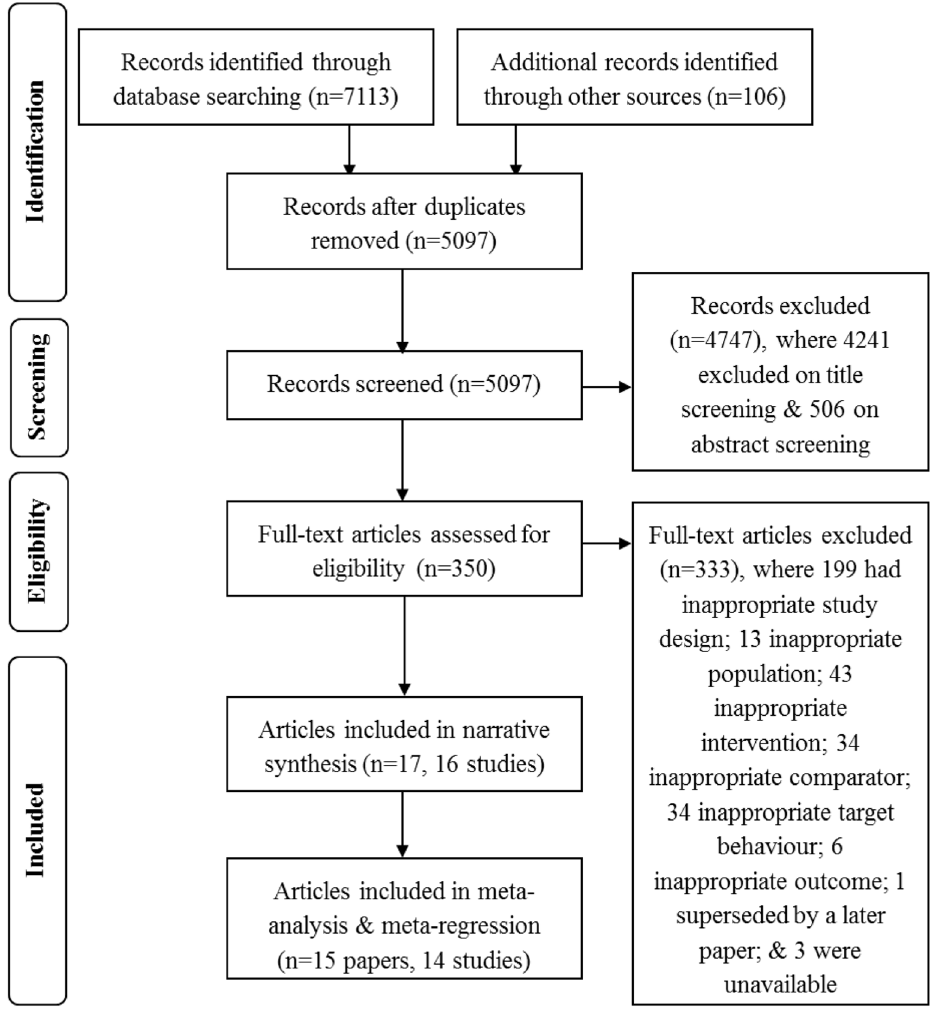
Figure 1. Flow diagram of study selection and exclusion.